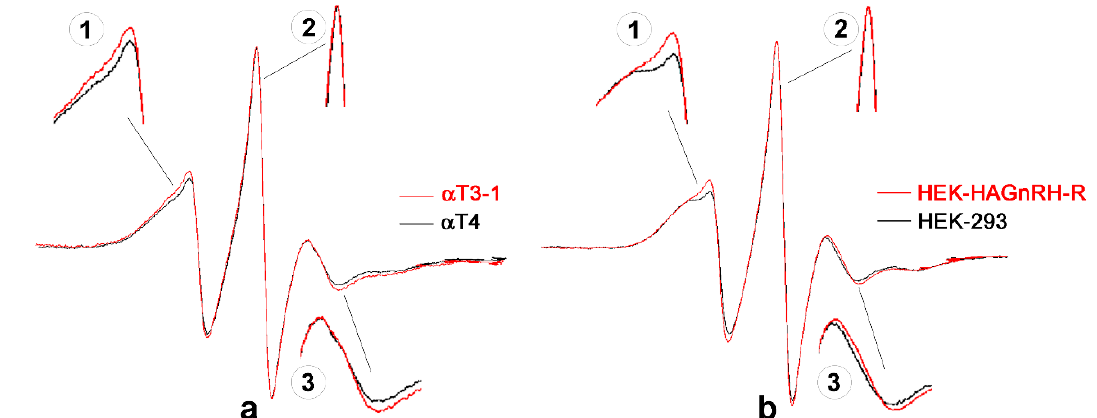
Figure 3. EPR spectra of the lipophilic spin probe MeFASL (10,3) in the PM of immortalized pituitary gonadotrope and heterologous cell lines. ( a ) EPR spectra of immortalized pituitary gonadotrope cell line ( α T3-1 cells; red line) and control gonadotrope progenitor cells lacking GnRH-R ( α T4 cells, black line). ( b ) EPR spectra of HEK-HAGnRH-R cell line stably expressing HA-tagged GnRH-R (red line) and of control, untransfected HEK-293 cells (black line). Insets 1, 2, 3, magnified portions of spectra showing the difference in line shape between cell lines lacking receptors and GnRH-R expressing cell lines.